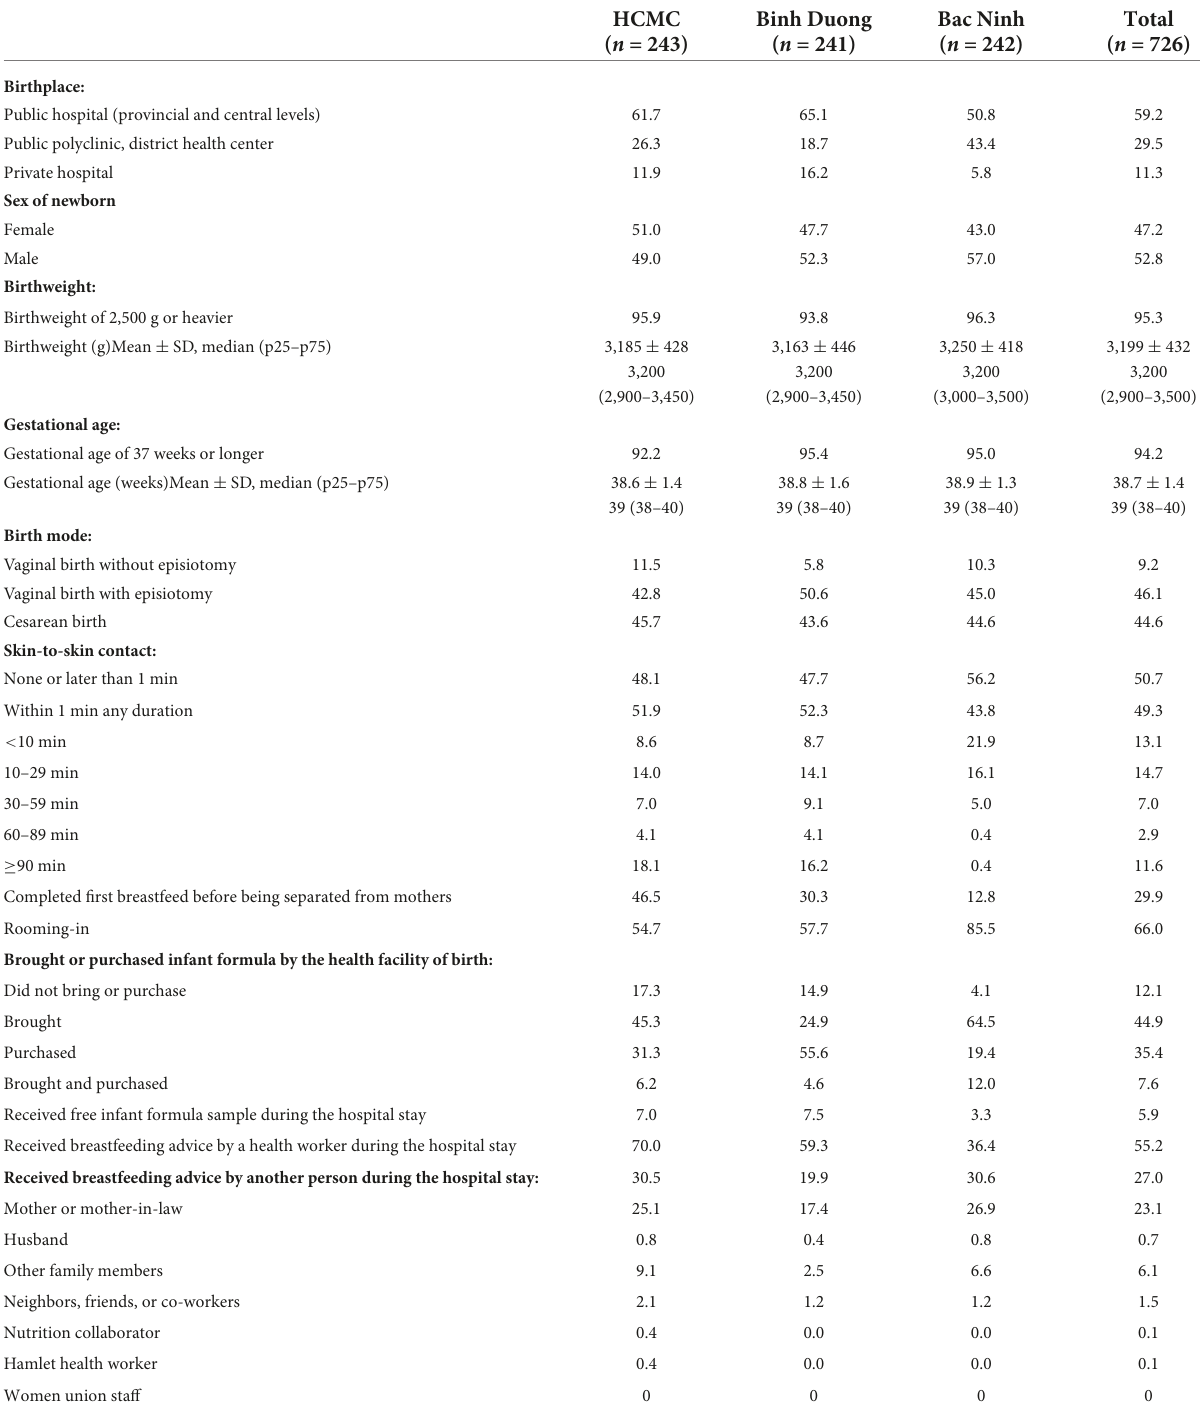
TABLE 4 Experience during the perinatal period reported by mothers of infants 0–11 months, three provinces, Vietnam 2020 1 .